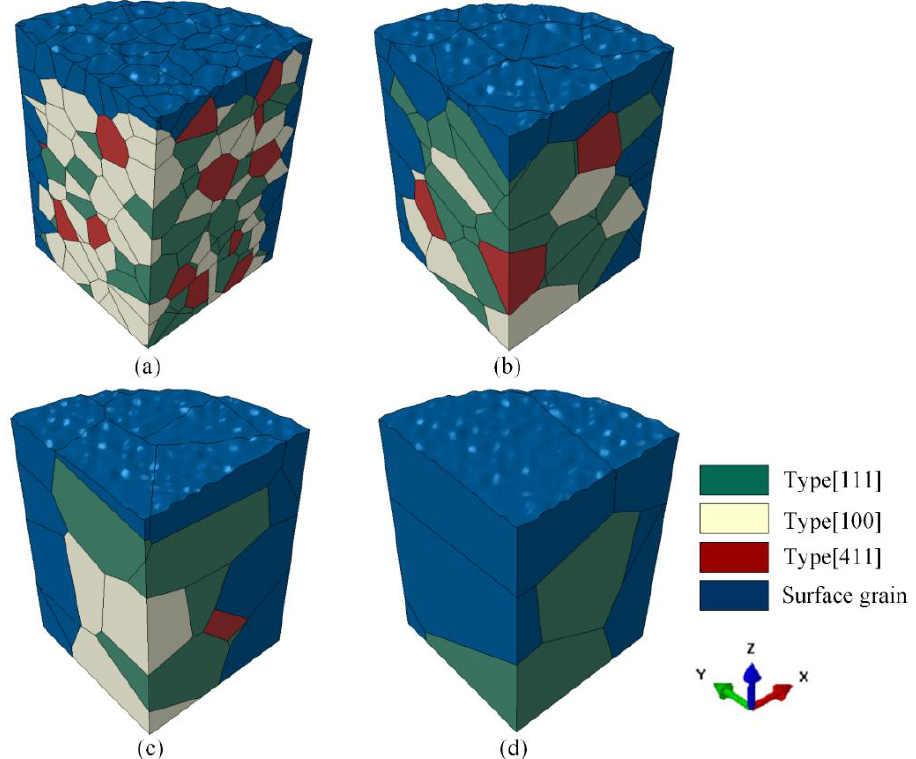
Figure 2. Assignment results for random orientations assignment results of the finite element models with different grain sizes ( a ) d = 30 μm; ( b ) d = 50 μm; ( c ) d = 80 μm; and ( d ) d = 120 μm.